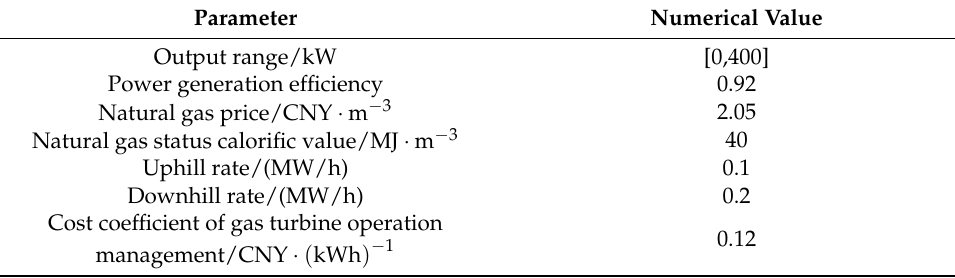
Table 3. The specific parameters of gas turbine.